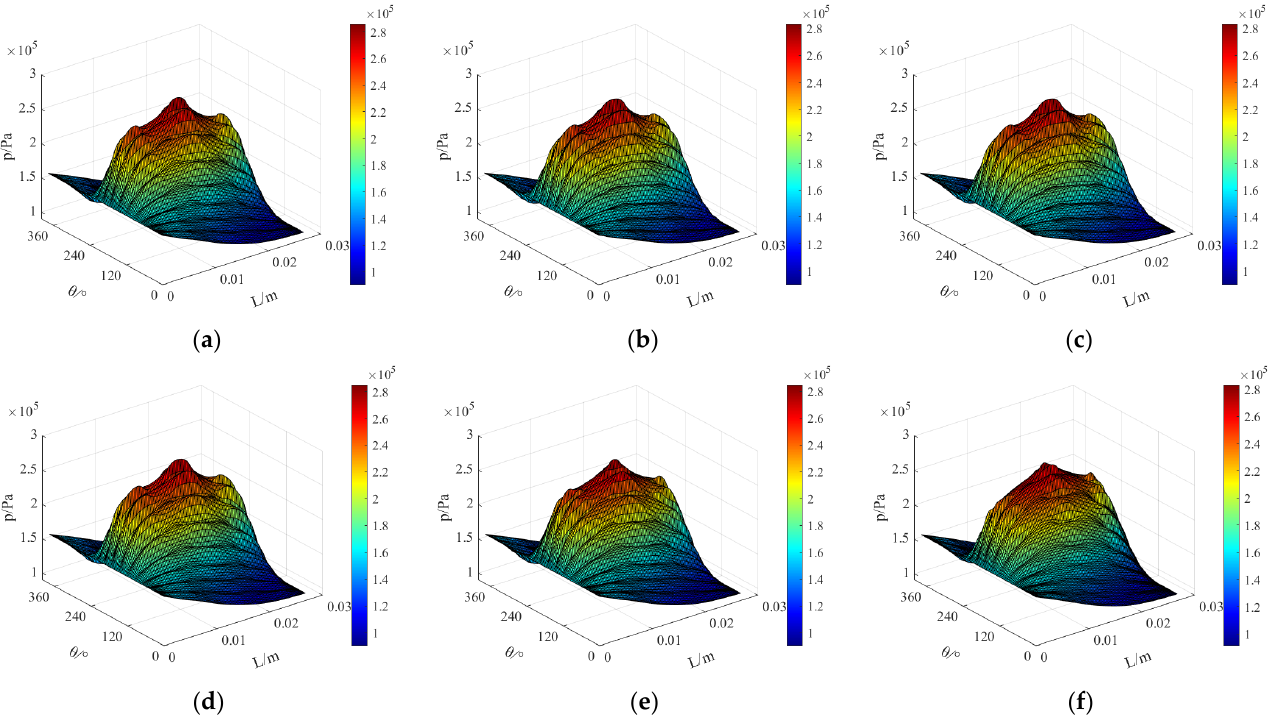
Figure 7. The pressure of the gas film with ( a ) circular texture ( b ) elliptical texture ( c ) triangular texture ( d ) square texture ( e ) diamond-shaped texture and ( f ) inverted triangular texture.